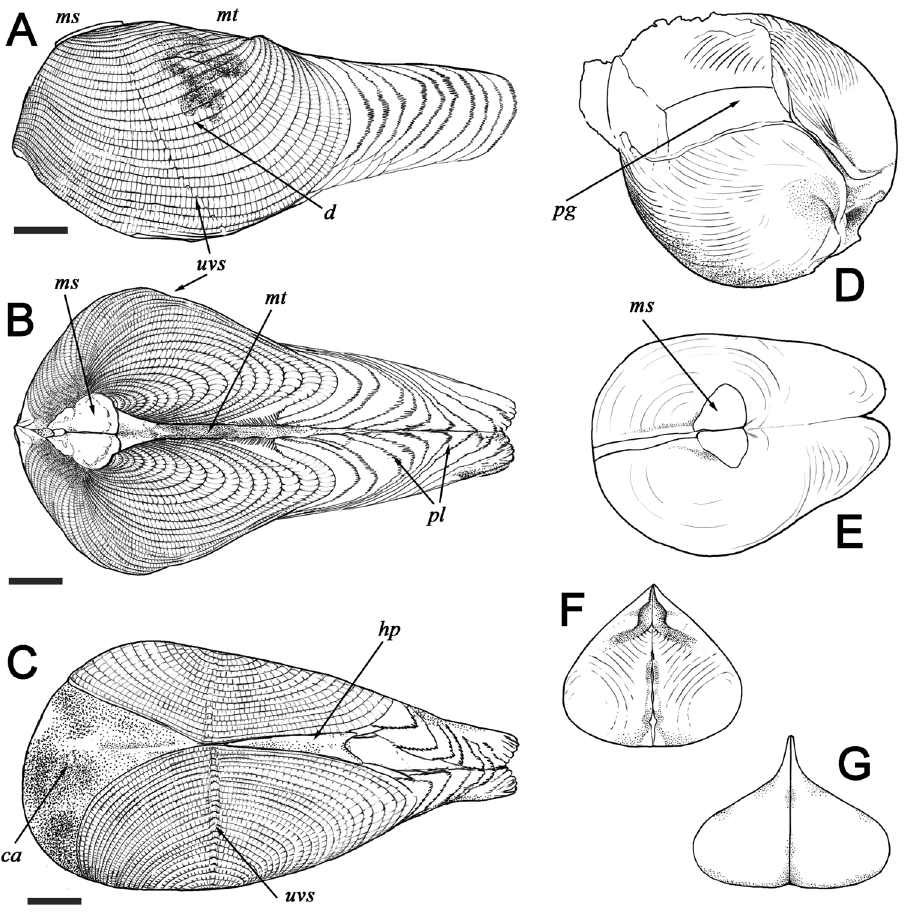
Figure 6. Schematic reconstruction of † Palaeolignopholas kachinensis gen. & sp. nov. from lower Cenomanian Kachin amber, northern Myanmar based on the type series and other fossil material 15,16,19,20 . ( A ) Lateral view of adult specimen. ( B ) Dorsal view of adult specimen. ( C ) Ventral view of adult specimen (based on a paratype BMNH 20205 15 ). ( D ) Anterio-ventral view of immature specimen. ( E ) Dorsal view of immature specimen. ( F ) Mesoplax of adult specimen. ( G ) Mesoplax of immature specimen. d disc; mt metaplax; ms mesoplax; hp hypoplax; ca callum; uvs umbonal ventral sulcus; pg pedal gape; pl periostracal lamellae. Scale bars = 1 mm ( A – C ). (Line graphics: Yulia E.